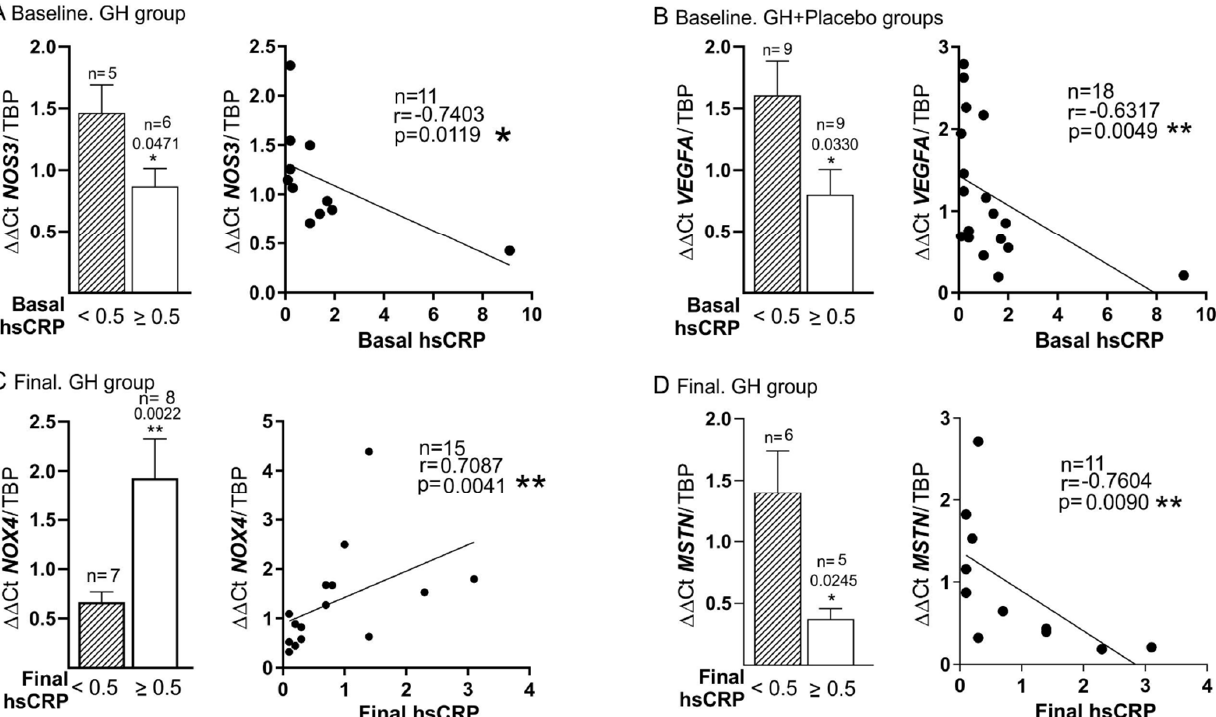
Figure 5. Correlation between plasma hsCRP and muscle gene expression in diabetic patients. ( A ). Baseline expression levels of hsCRP and NOS3 in the GH group. ( B ). Baseline hsCRP and VEGFA levels in both groups. ( C ). Final hsCRP and redox stress levels measured by final NOX4 in the GH-treated patients. ( D ). Final hsCRP levels were related to final MSTN mRNA expression in GH group. Striped bars: hsCRP < 0.5; White bars: hsCRP ≥ 0.5. * p < 0.05; and ** p < 0.001.